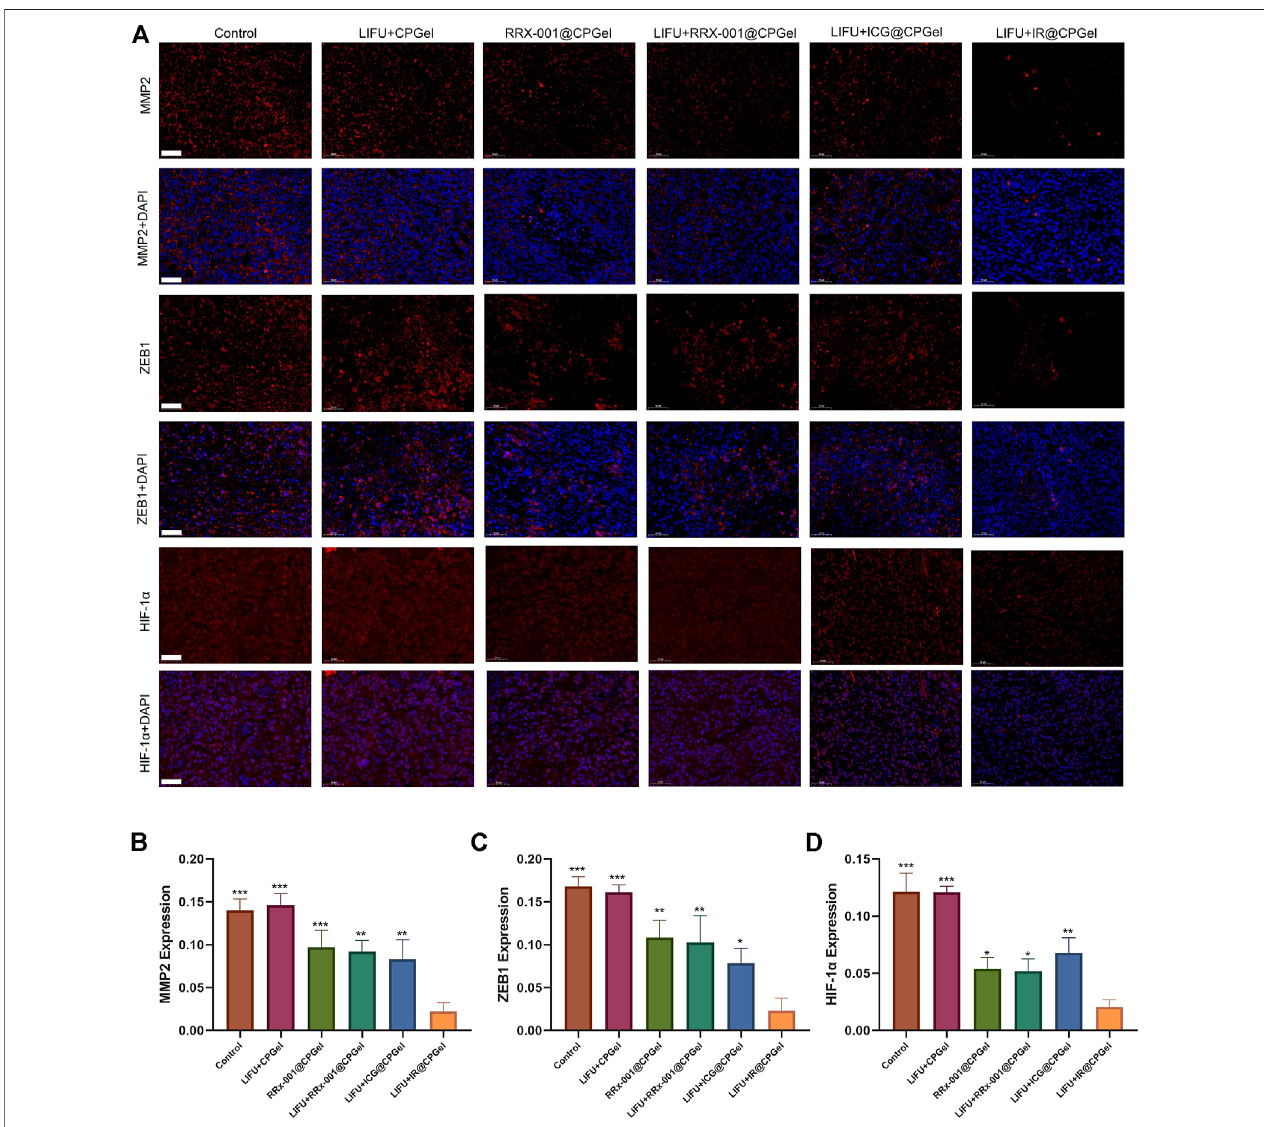
FIGURE 5 | (A) Immuno fl uorescence analysis of MMP-2, ZEB1 and HIF-1 α expression levels in mouse tumors treated with different formulations; scale bar = 50 µm. Semiquantitative analysis of MMP-2, ZEB1 and HIF-1 α expression levels in mouse tumors treated with different formulations. All data are shown as the mean ± SD. (n = 3), p p < 0.05, pp p < 0.01 and ppp p < 0.001 vs. the LIFU + IR@CPGel